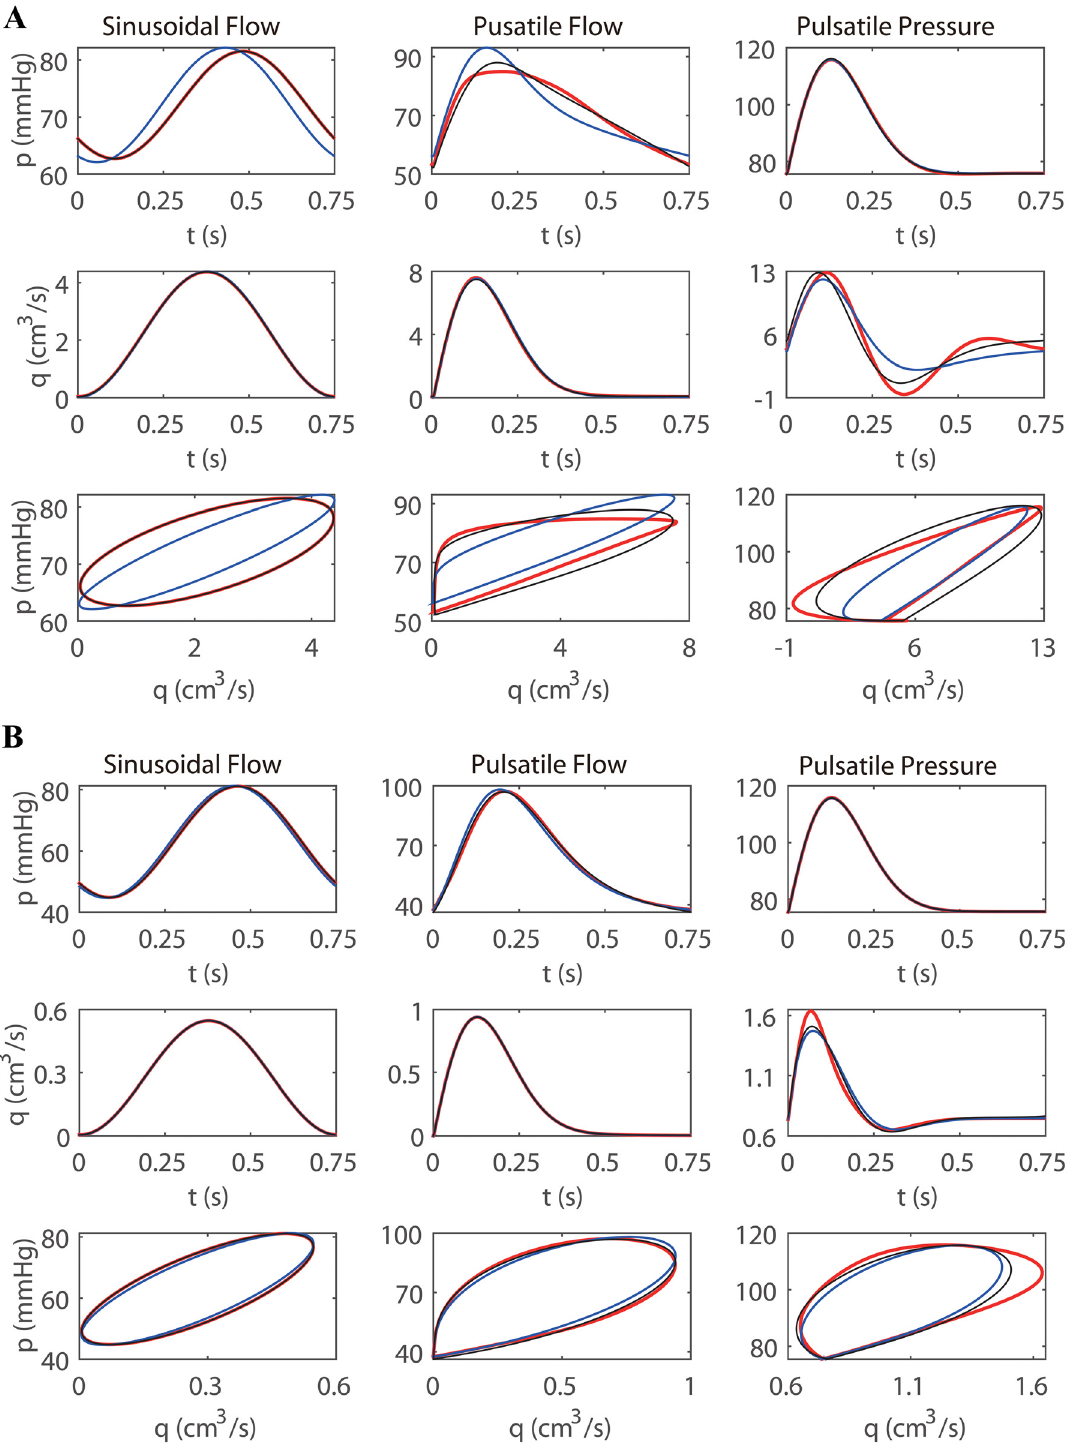
Fig 4. Time profiles and phase profiles of the blood pressure and flow rate at the mid-point of a single artery. The unstressed radii for Figure A and B are 0.26 cm and 0.13 cm , respectively. The left, middle, and right panels are obtained with the sinusoidal flow input ( Eq (27)), the pulsatile flow input (Eq (28)), and the pulsatile pressure input (Eq (29)), respectively. The red, black, and blue lines correspond to the results obtained with ST, CWK, and WK models,